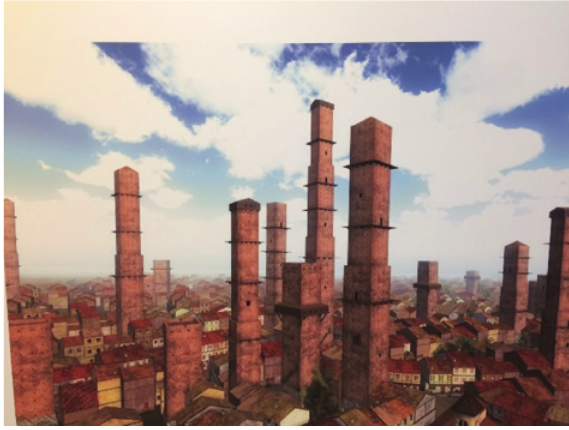
Figure 3: Medieval towers of Bologna. Courtesy of The Time Machine by Genus Bononiae. Museum in the City (Bologna) and TOWER and POWER.